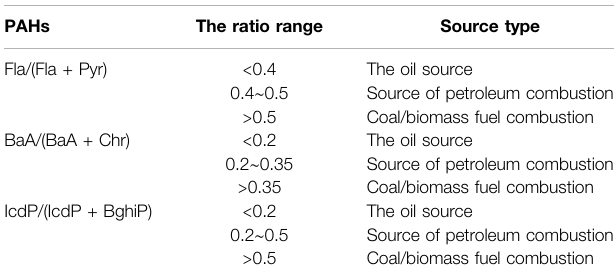
TABLE 5 | Feature ratios and source types of